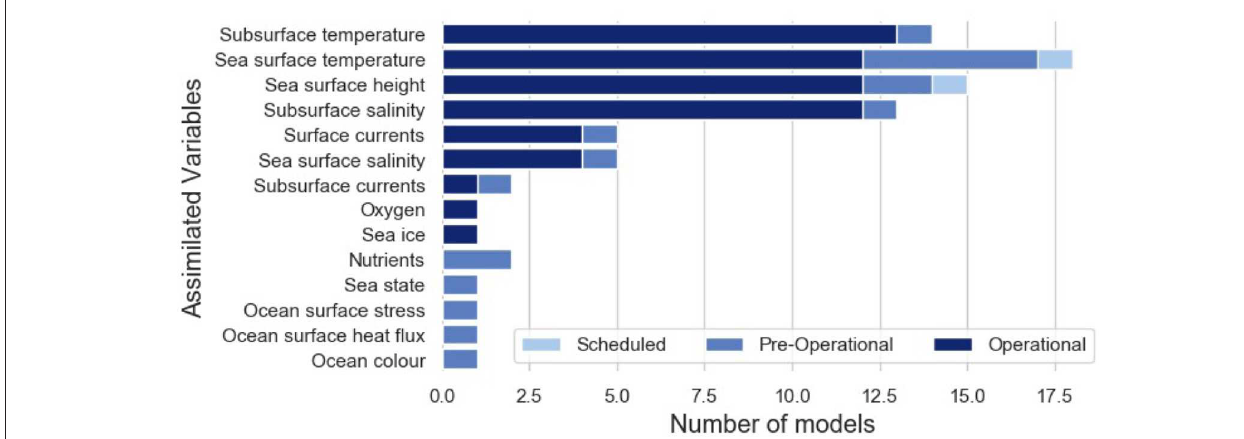
FIGURE 12 | Essential ocean variables being assimilated in operational modeling systems.